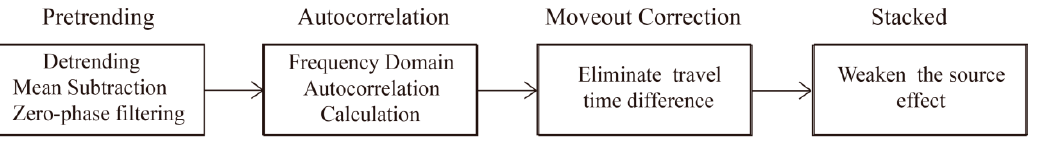
Figure 5. Schematic diagram of data processing flow.